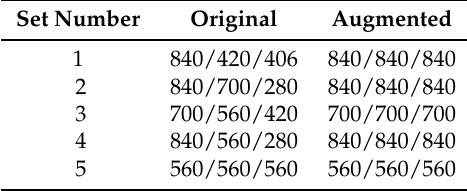
Table 1. Sample counts for each class before and after data augmentation. Values in each cell are presented in the following order: green, yellow,